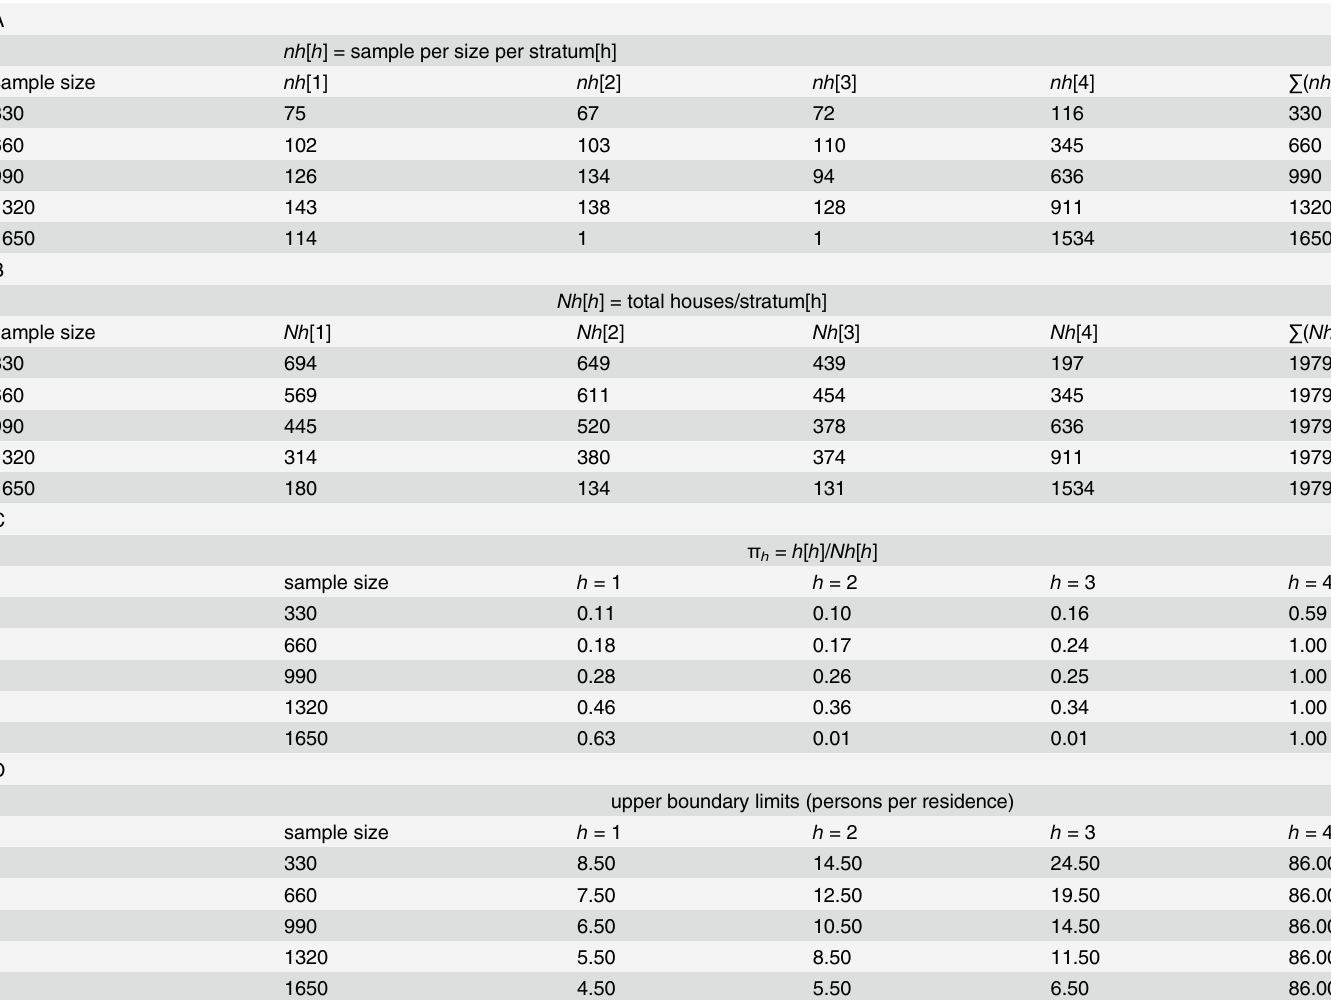
Table 2. Neyman-optimized allocation as a function of sample size and stratum.